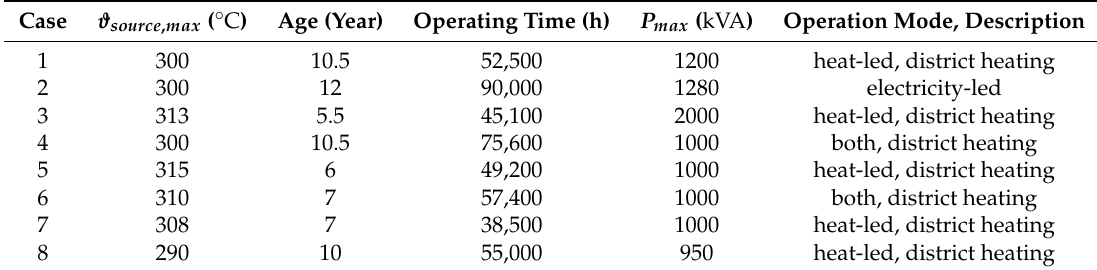
Table 1. Boundary and operating conditions for seven case study ORC power plants (1–7) and one test power plant (8).